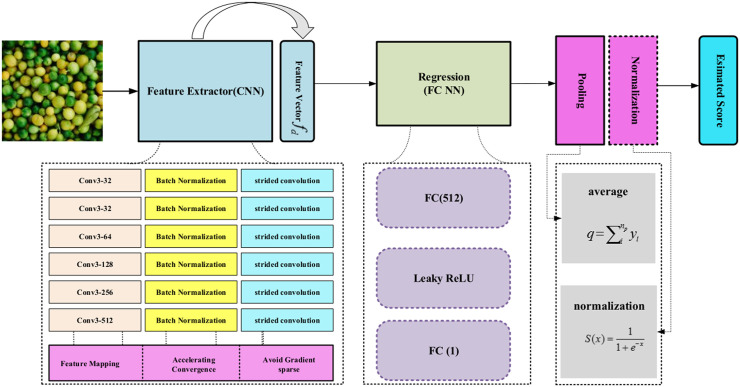
Architecture of the IQA net, where the feature extraction is realized by cascading convolutional layers in five levels.